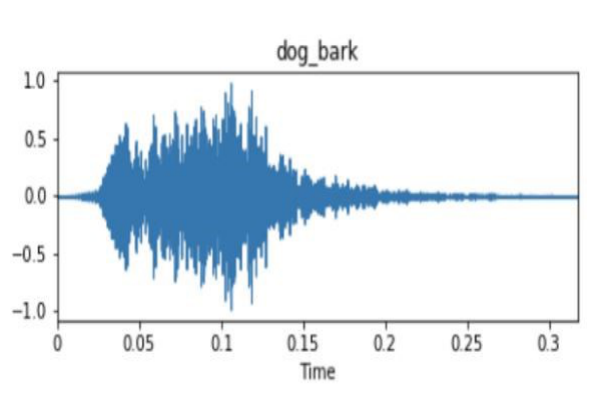
Fig. 2. Audio Signal Waveform